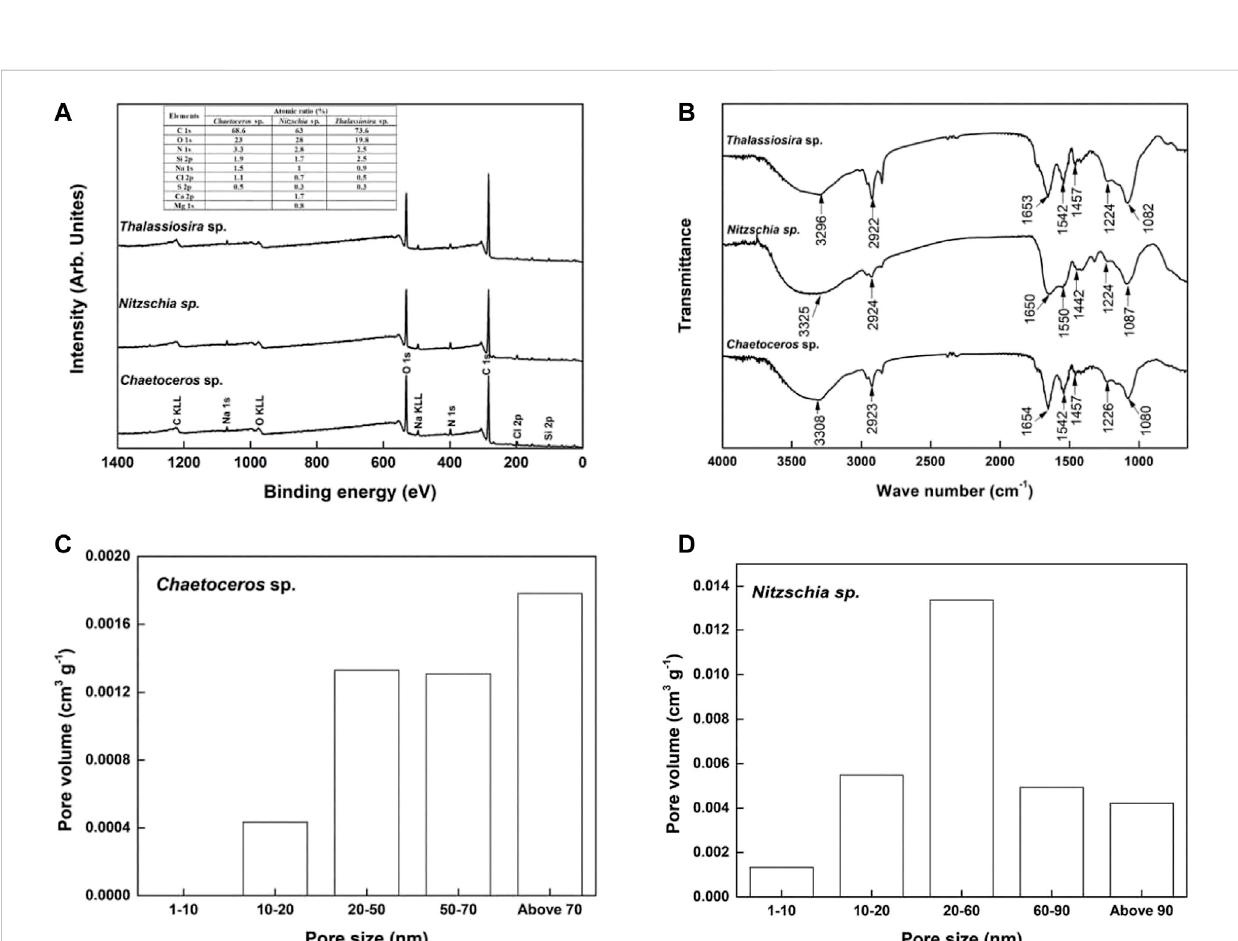
FIGURE 2 Properties of non-living diatom biomass. (A) XPS spectrum, (B) FTIR spectrum, and (C – D) Pore size distribution.